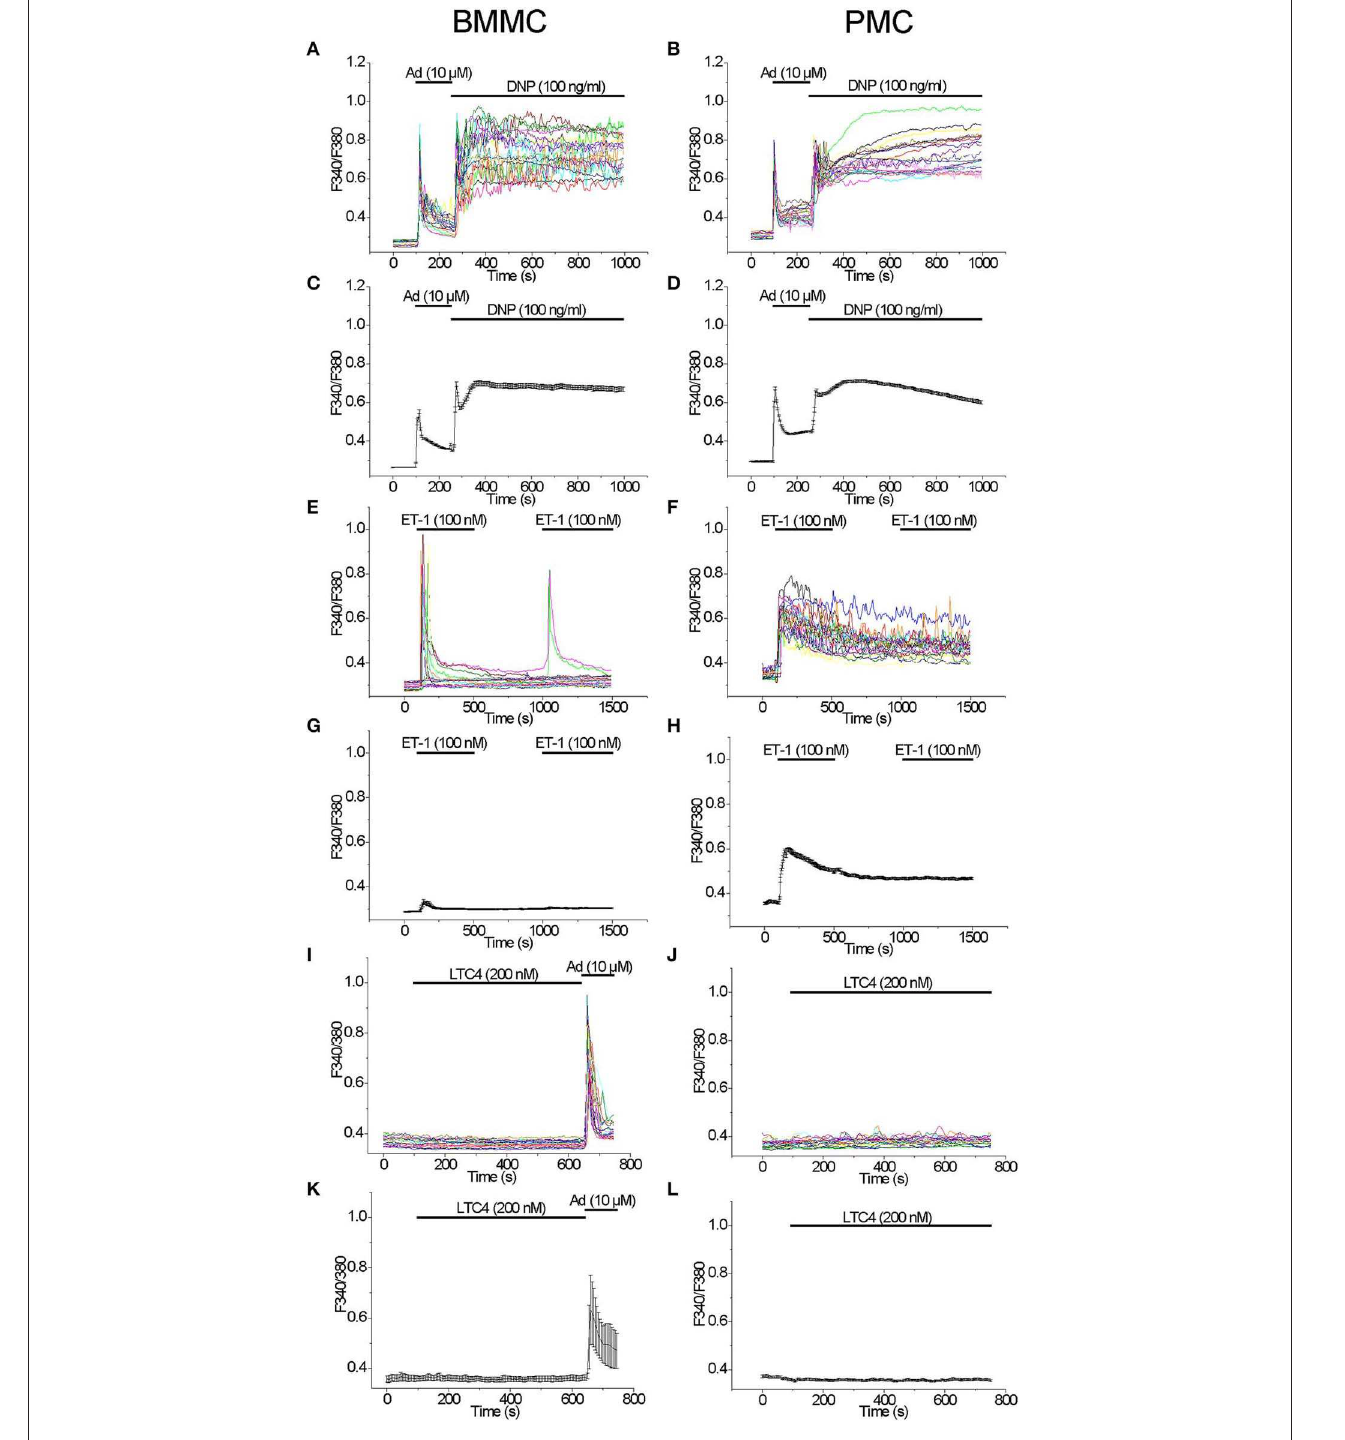
FIGURE 1 | Comparison of [Ca 2 + ] i rise induced by different agonists in BMMC and PMC. Measurements of [Ca 2 + ] i changes performed with Fura-2 and presented as F340/F380 fluorescence ratio in BMMC (A,C,E,G,I,K) and PMC (B,D,F,H,J,L) isolated from WT mice. Representative traces ( n = 20 each panel) of [Ca 2 + ] i changes (error bars indicate S.E.M.) induced by application of: 10 µ M Adenosine (Ad) and subsequently DNP (100ng/ml) (A–D) , 100nM Endothelin-1 (ET-1) (E–H) , 200nM LTC4 (I–L) . The measurements were performed in 3–5 independent cell preparations. At the end of recordings, control reactions were elicited by application of 10 µ M adenosine (Ad) (I,K)